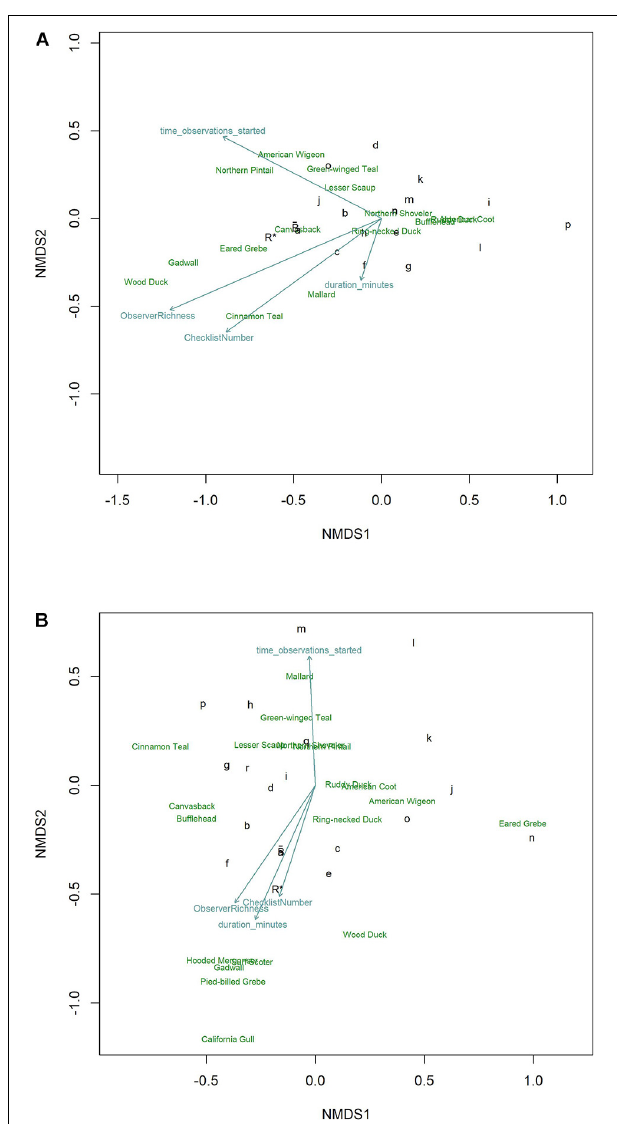
FIGURE 6 | Ordinations using NMDS of eBird checklists’s characterization of the waterbird community during (A) January and (B) October at Philomath ponds, Oregon USA, 2010–2019. The most influential vectors included Observer Richness (percent of known richness reported on each checklist), Checklist Number (total number of checklists per observer), observation start time each day, and the duration of each observation period. Relative positions of species in species space are noted by species English names. Benchmark counts are noted by R *. Individual observers are noted by lower case letters; those nearest to R * produced characterizations of the waterbird community most like R *. B is the collective average of eBird checklists, showing that from the perspective of generally characterizing the community, averaging across checklists contributed by many observers aligns more closely with R * than do checklists from most individual observers, although observer a occupies nearly the same location in species space.